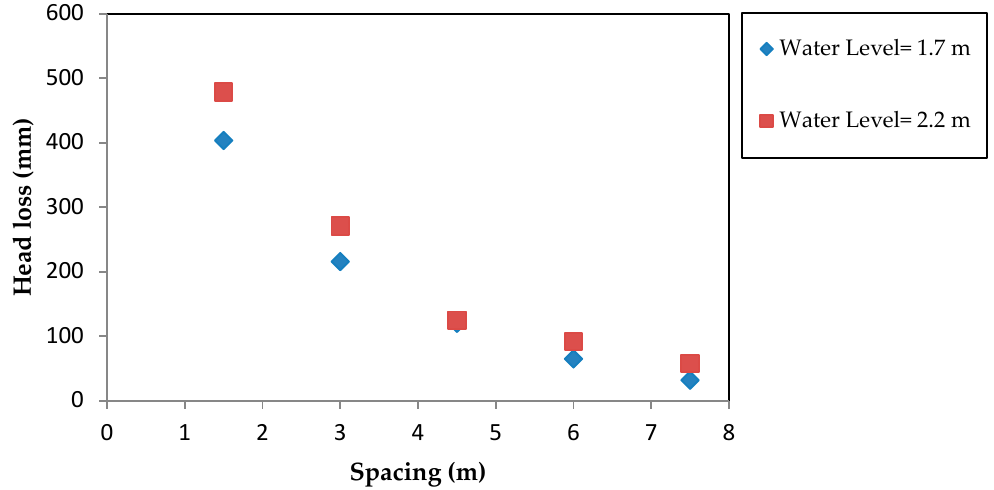
Figure 4. Relationship between the head loss and the outlet spacing for two inlet heads (AR = 0.24).